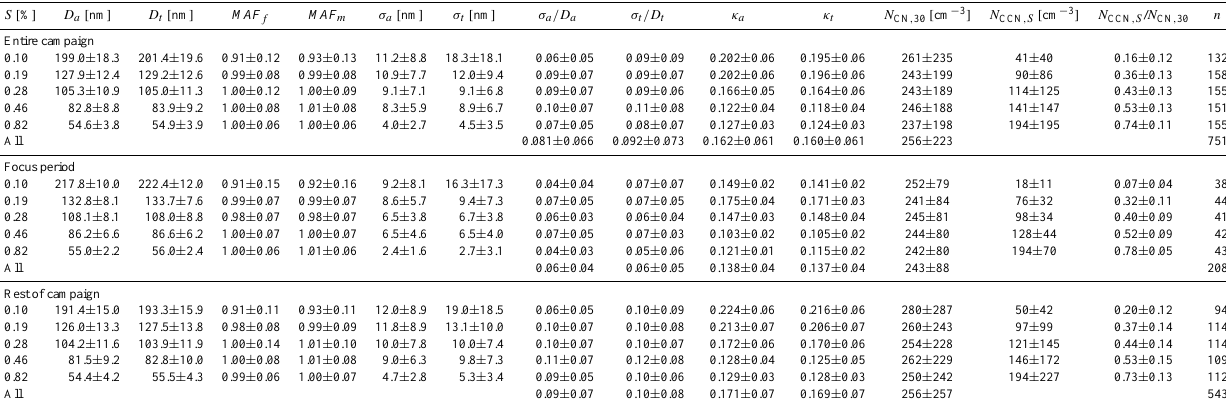
Table 1. Characteristic CCN parameters (arithmetic mean values ± standard deviations) averaged over the entire campaign (14 February– 12 March 2008), over the pristine focus period (6–12 March, 22:00UTC), and over the rest of the campaign (14 February–6 March): midpoint activation diameters ( D a , D t ), maximum activated fractions ( MAF f , MAF m ), heterogeneity parameters ( σ a / D a , σ t / D t ), hygroscopicity parameters ( κ a , κ t ), number concentrations of aerosol particles with D> 30nm ( N CN , 30 ), number concentrations of cloud condensation nuclei ( N CCN , S ), integral CCN efficiencies ( N CCN , S / N CN , 30 ), number of data points ( n ). Subscripts a and t stand for parameters derived from 3-parameter and 2-parameter CDF fits to the measured CCN efficiency spectra, respectively. For corresponding median values see Table S1 (online supplement: http://www.atmos-chem-phys.net/9/7551/2009/acp-9-7551-2009-supplement.pdf). Concentration values are normalized to a reference state of 273K and